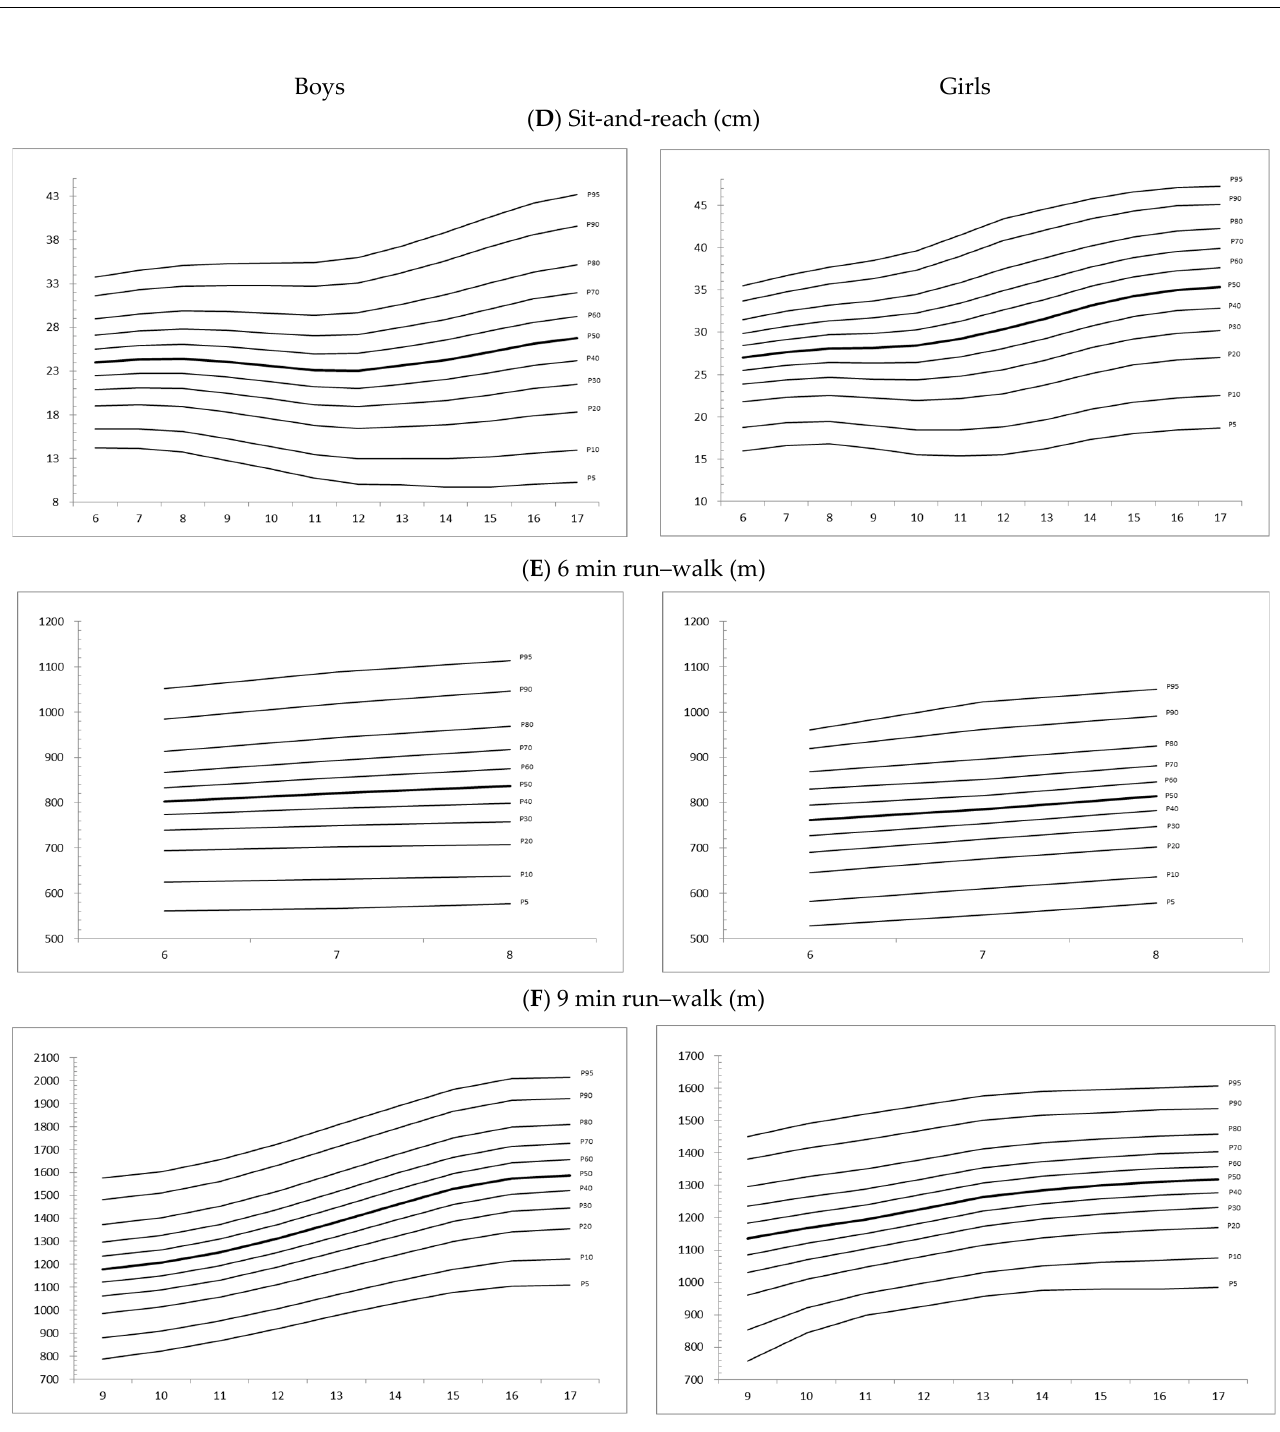
Figure 1. Normative value of handgrip strength, push-up, 1 min sit-up, sit-and-reach, 6 min and 9 min run–walk for boys and girls. a Modified knee-bend push-up was used for girls .